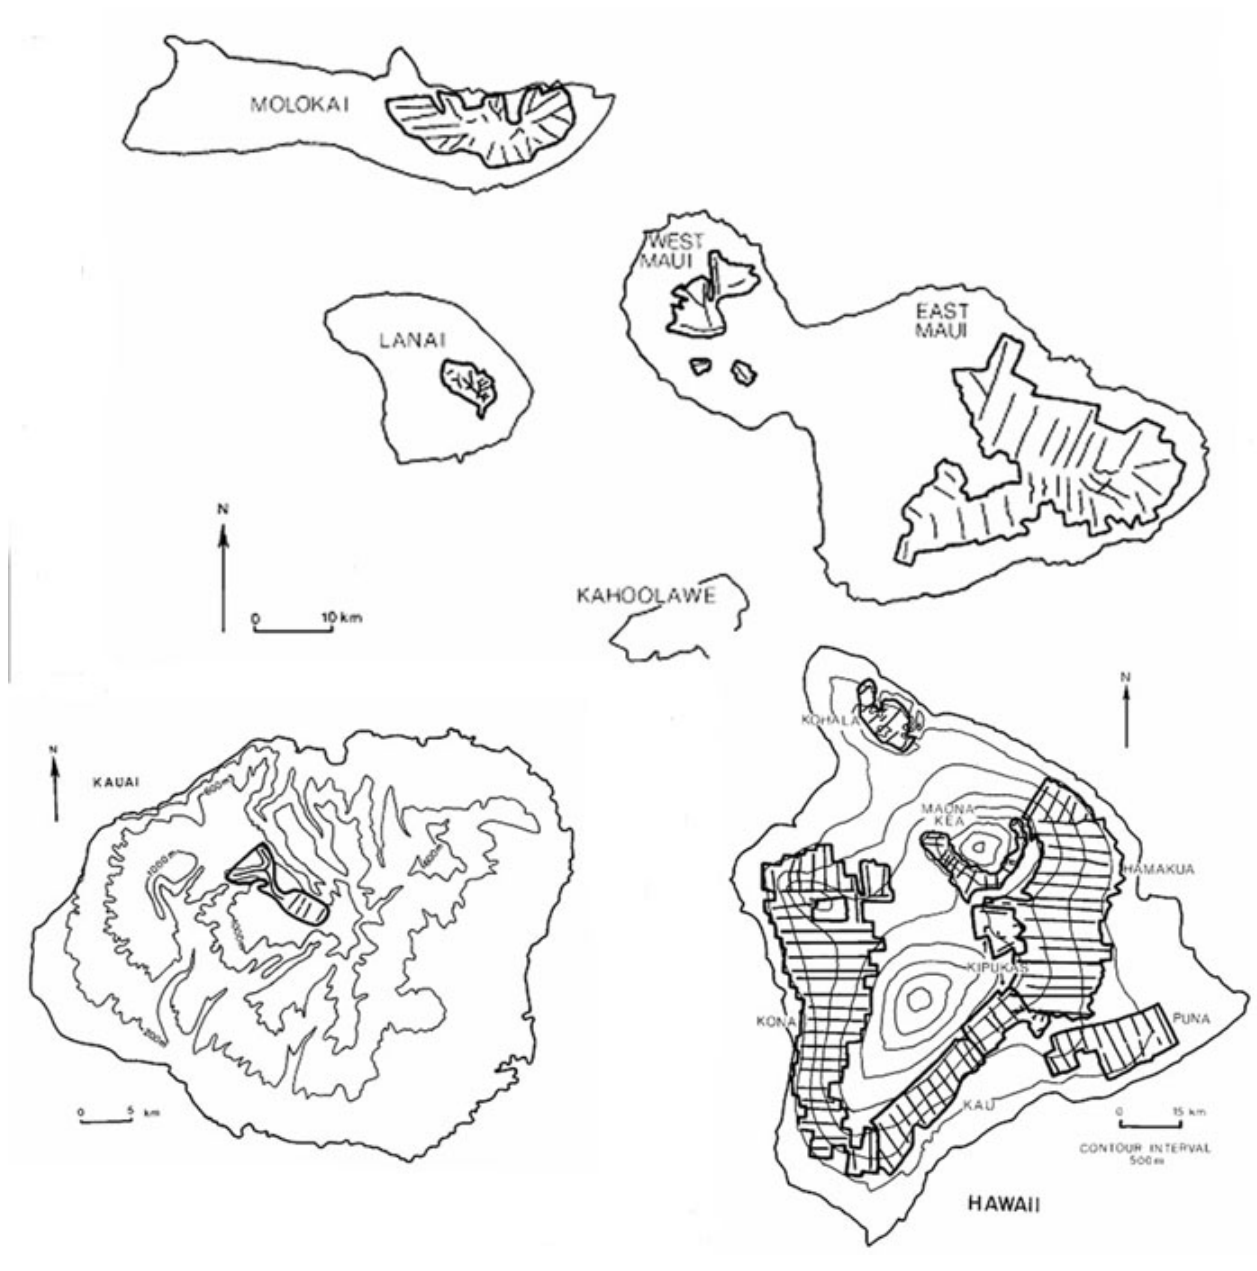
Fig. 2. Map showing the transect areas for the Hawaiian Forest Bird Surveys. From Scott et al.